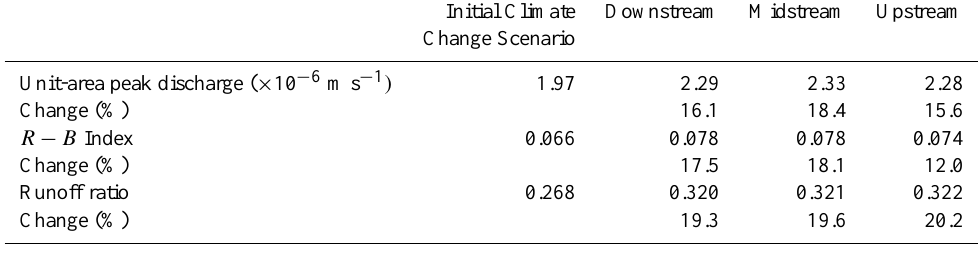
Table 5. Hydrological response characteristics for different distributions of land cover change in three sections (downstream, midstream, and upstream areas) of one watershed, WS4. The three simulations use the predicted (2040) climate parameters, percent changes for indices are compared to the initial climate change scenario for that watershed.